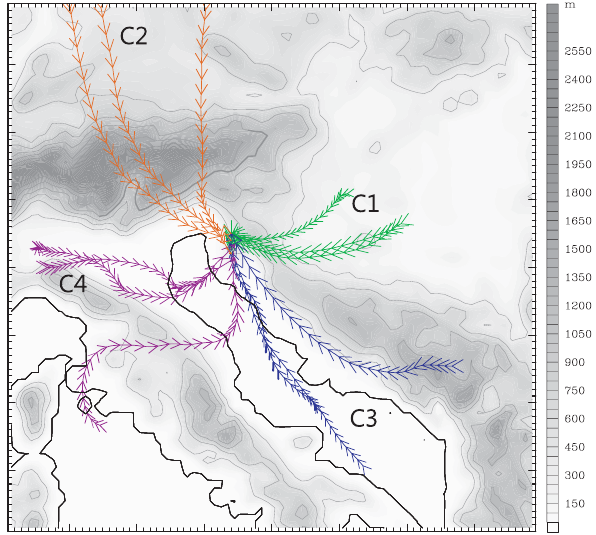
Fig. 2. Depicted are 27h three-dimensional backward trajecto- ries arriving at the three nearby points (grey dots Pazin, S1, S2 in Fig. 1a) in Istria at 16:00CET for four examined cases: on 9 July 2006, (case C1; green), 8 August 2006 (case C2; orange), 8 June 2003 (case C3; blue) and 7 July 2009 (case C4; violet). The trajectories were calculated at 13.5km horizontal resolution within the largest model domain at 500hPa level and arrows represent par- cel positions for every